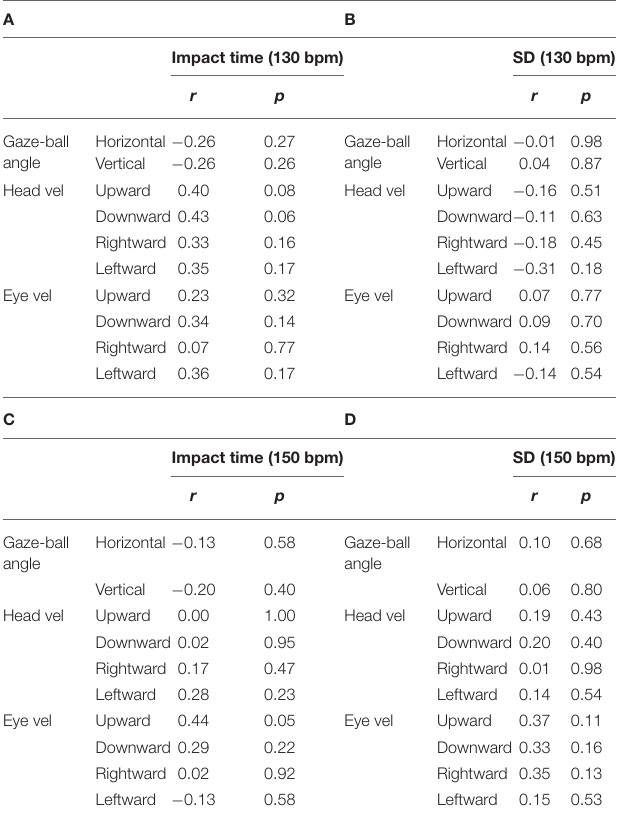
TABLE 4 | Pearson correlation between the hight of participants and the gaze-ball angle, eye velocity, and head velocity in each